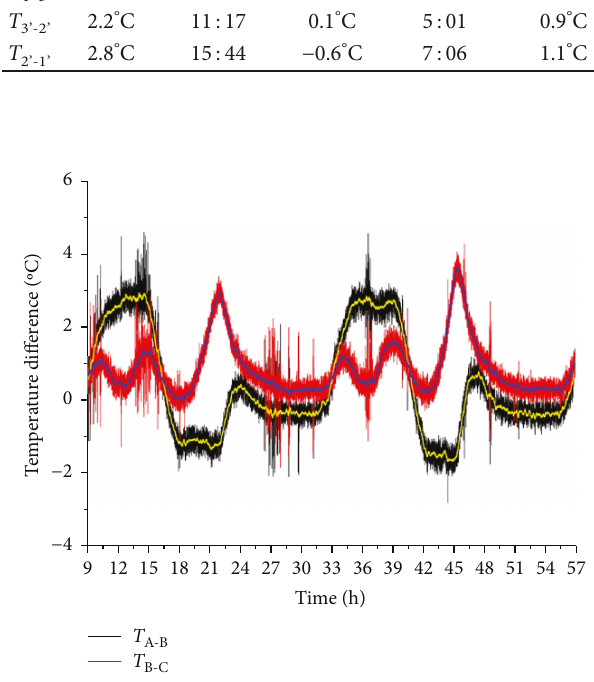
Figure 8: Temperature variation comparison for the nodes on the internal surface of center